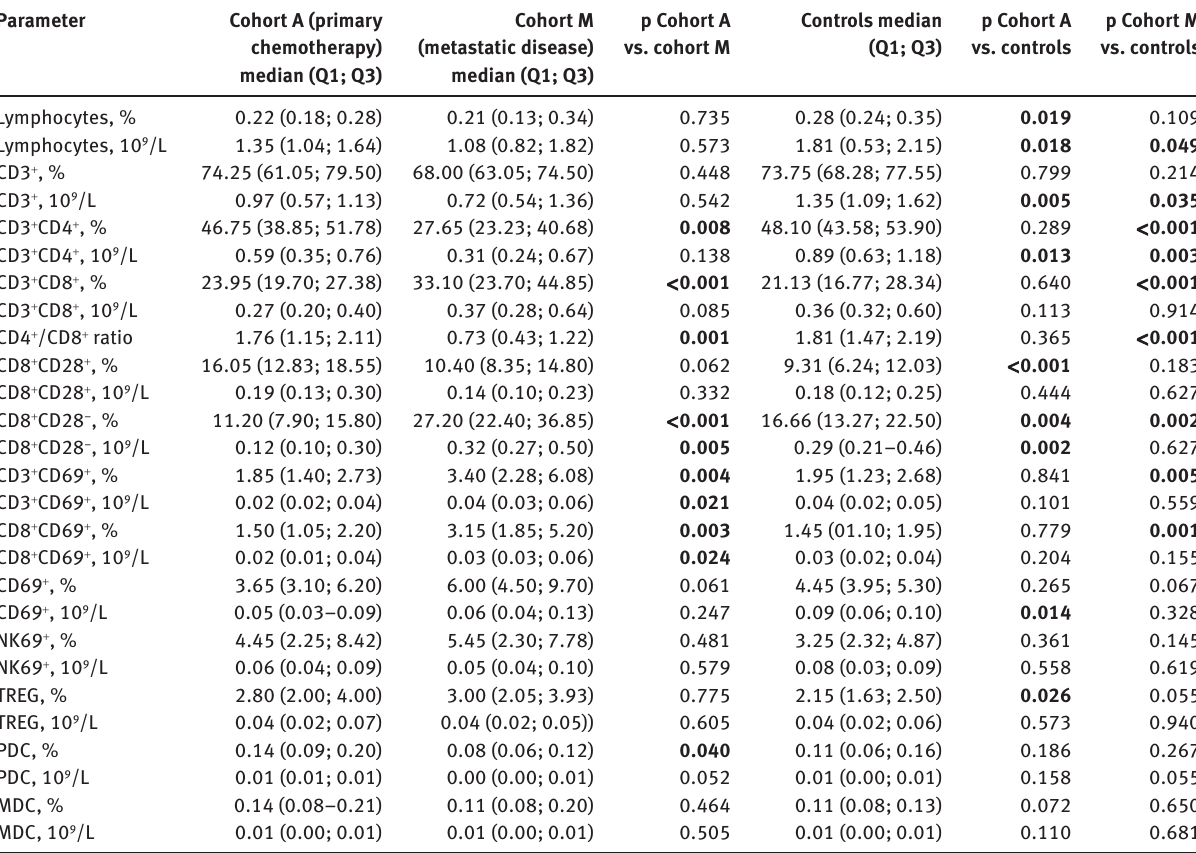
Table 1: Baseline peripheral blood leukocyte phenotype.